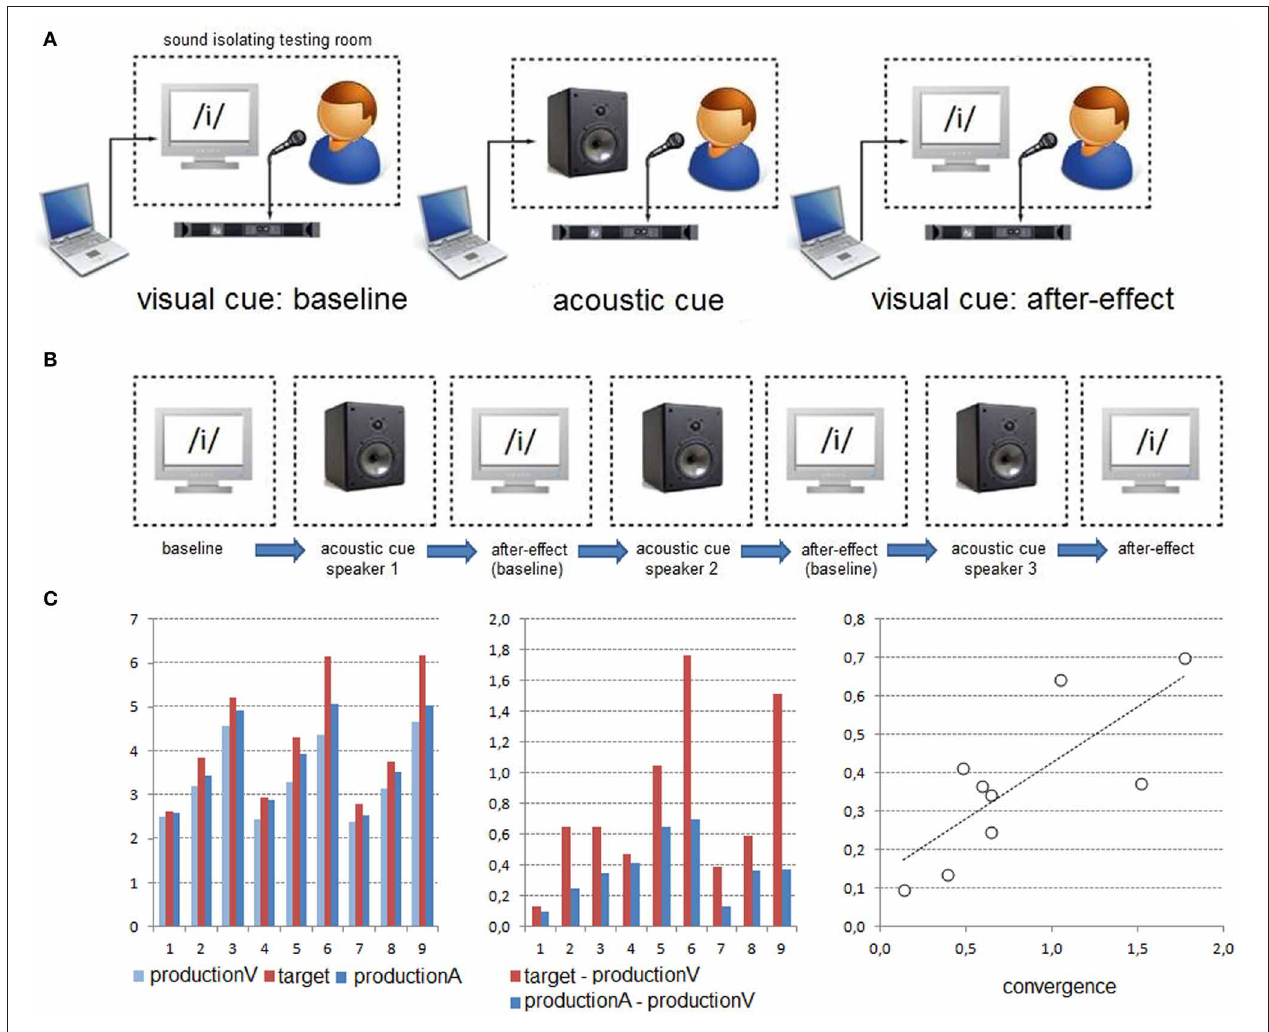
FIGURE 1 | Experimental procedure. (A) In each block, participants were consecutively presented with orthographic, acoustic (previously recorded from a single speaker) and again orthographic vowel targets. The experimental design and apparatus were identical in the production, imitation and categorization experiments, except the task required during the presentation of the acoustic targets (i.e., vowel production, vowel imitation, and manual vowel categorization). This procedure allowed determining unintentional/automatic in the production experiment or voluntary imitative changes in the imitation experiment, as well as possible after-effects in the